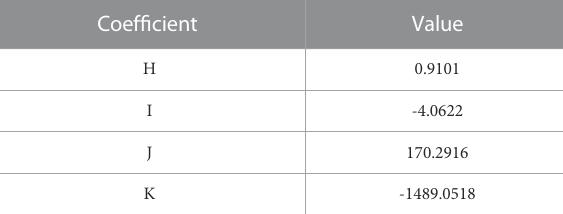
TABLE 5 Viscosity model coef fi cients of nano-LiBr with